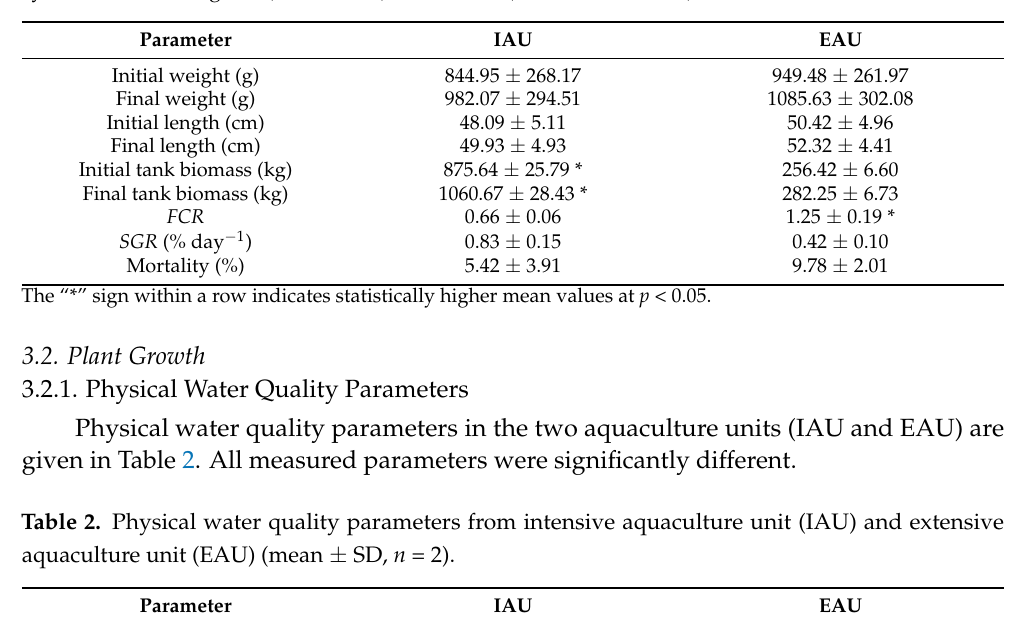
Table 2. Physical water quality parameters from intensive aquaculture unit (IAU) and extensive aquaculture unit (EAU) (mean ± SD, n = 2).